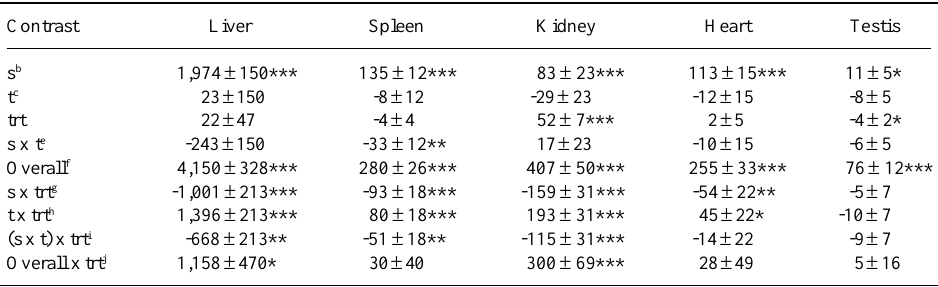
Table III - Orthogonal contrasts ± SE involving NC, NM, TC, TM and CC lines a for absolute 8-week organ weights (mg).